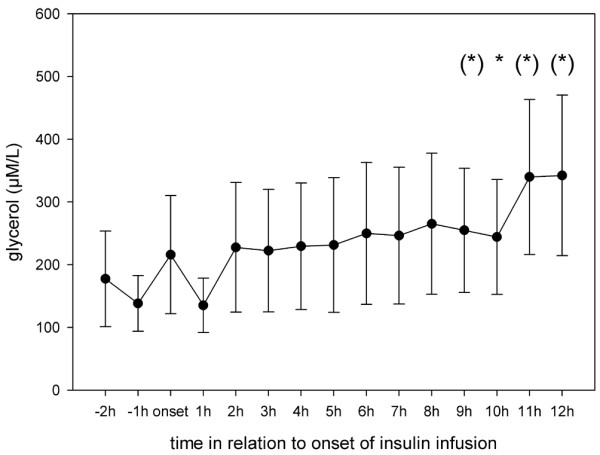
Course of cerebral extracellular glycerol during insulin infusion. Data are expressed as mean ± standard error of hourly microdialysate concentrations from 24 patients treated with continuous intravenous insulin. Levels of significance are indicated for comparison with microdialysate concentrations at the start of insulin infusion (Wilcoxon signed-rank test). *P < 0.05; (*)P < 0.1.